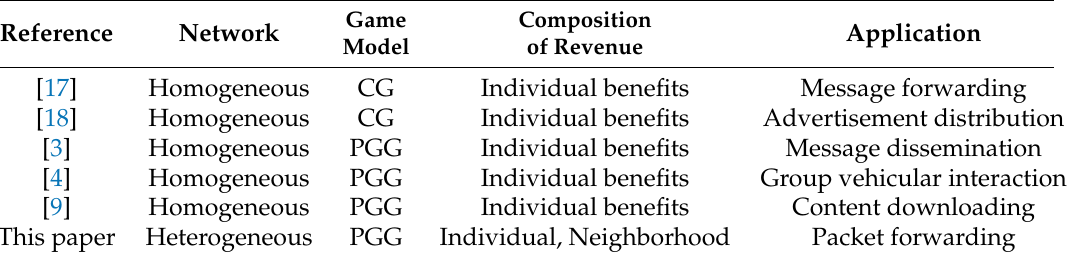
Table 1. Comparison of DAPGG with several previous